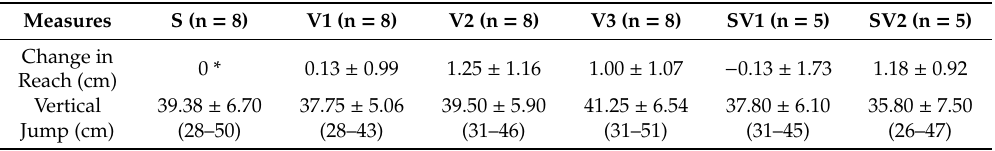
Table 2. Reach change scores (mean ± SD) and vertical jump results (mean ± SD (range)) by clothing